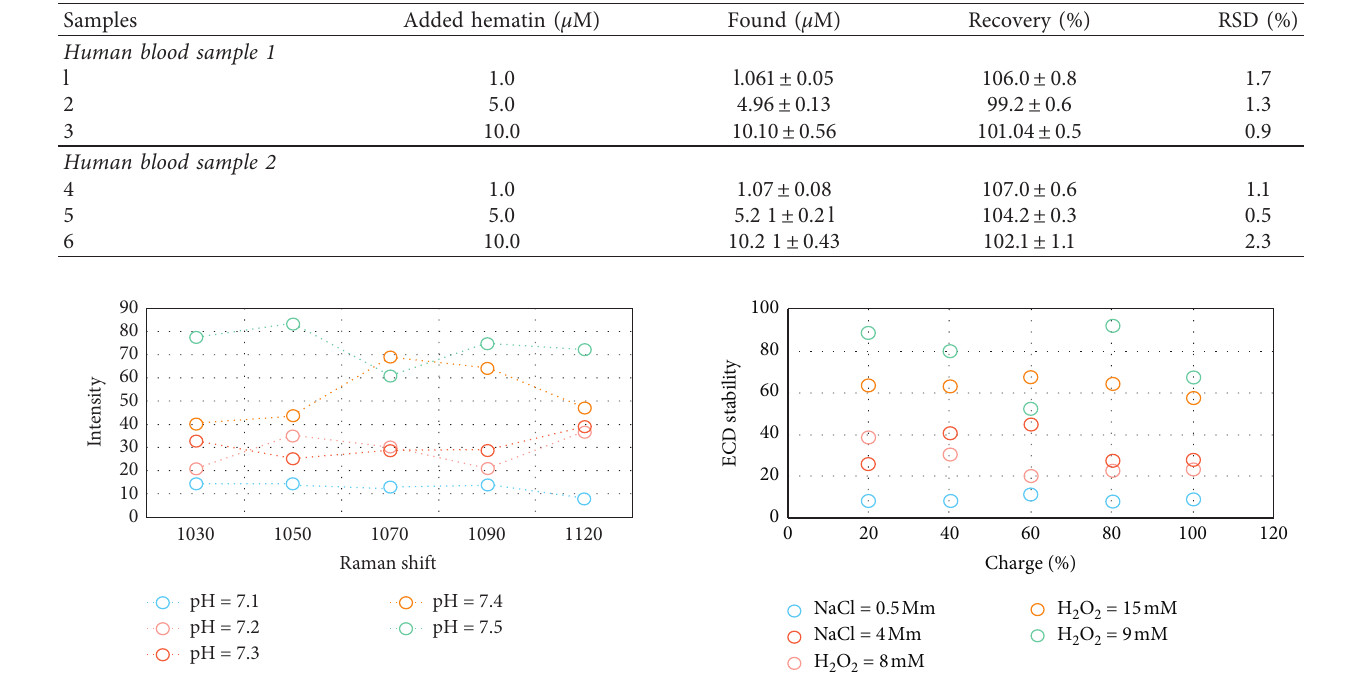
Figure 1: Raman spectra of probes in different control systems.